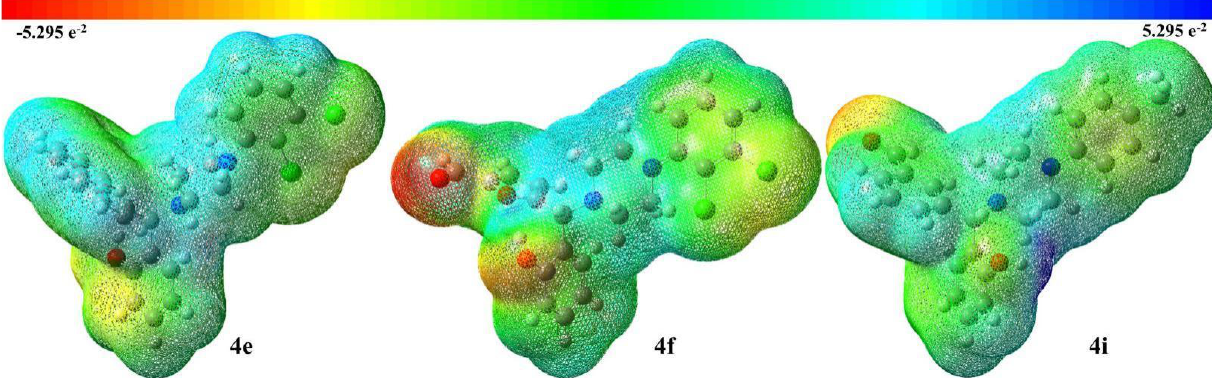
Figure 4. Computed molecular orbital plots for synthesized molecules 4k-4r with the counter value of 0.02 Å − 3 .